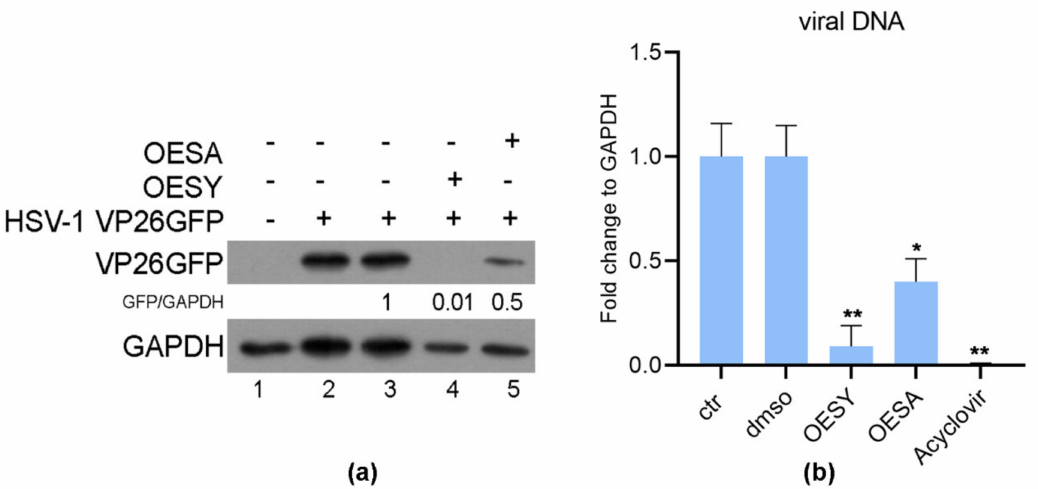
Figure 4. OESA and OESY prevent the binding of HSV-1. Vero cells infected or uninfected with HSV-1 VP26GFP, as described in the Materials and Methods section. Samples were processed 24 h p.i. for western blot analysis ( a ) and real-time PCR ( b ). DNA extracted from Vero cells infected and treated with Acyclovir (20 µ M) was used as a positive control for the quantization of viral DNA. Data are expressed as the mean ( ± SD) of at least three experiments, and asterisks (* and **) indicate the significance of p -values less than 0.05 and 0.01, respectively. OESY, extract of O. europea var. sylvestris ; OESA, extract of O. europea var. sativa